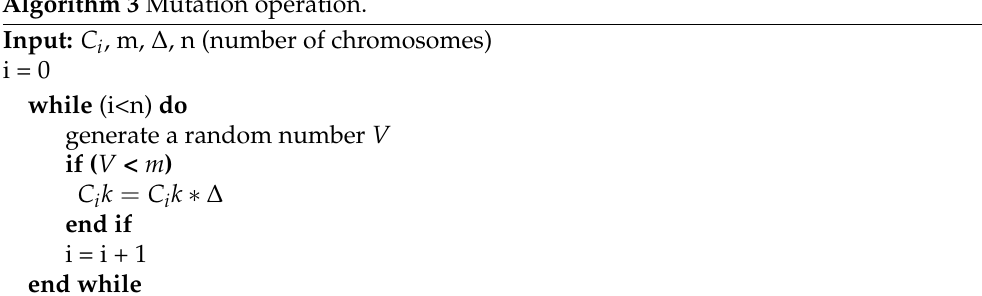
Figure 7. Mutation operation. Algorithm 3 Mutation